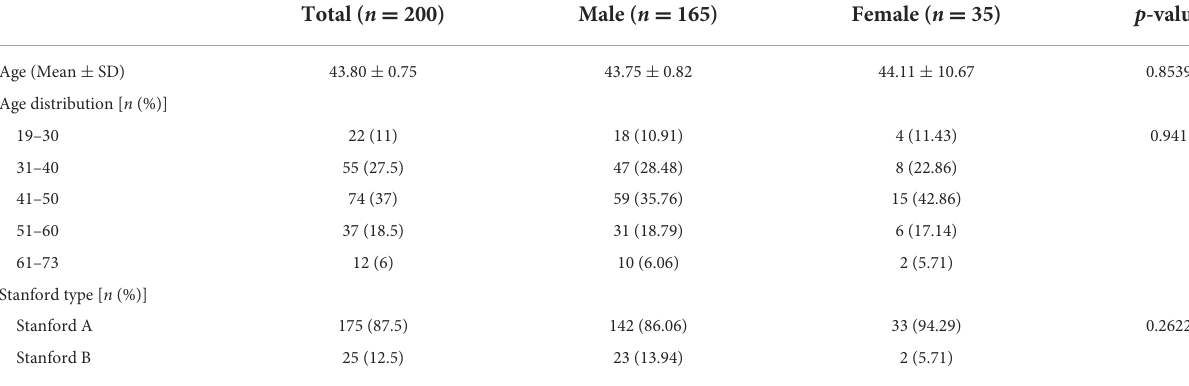
TABLE 1 Demographic characteristics of TAD cases.